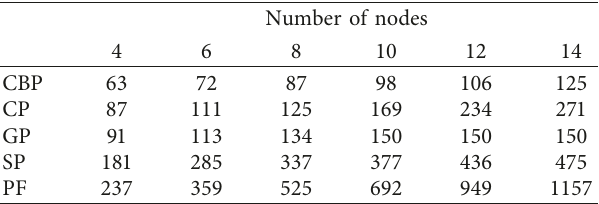
Table 1: The average number of transmitted packets for each successfully received